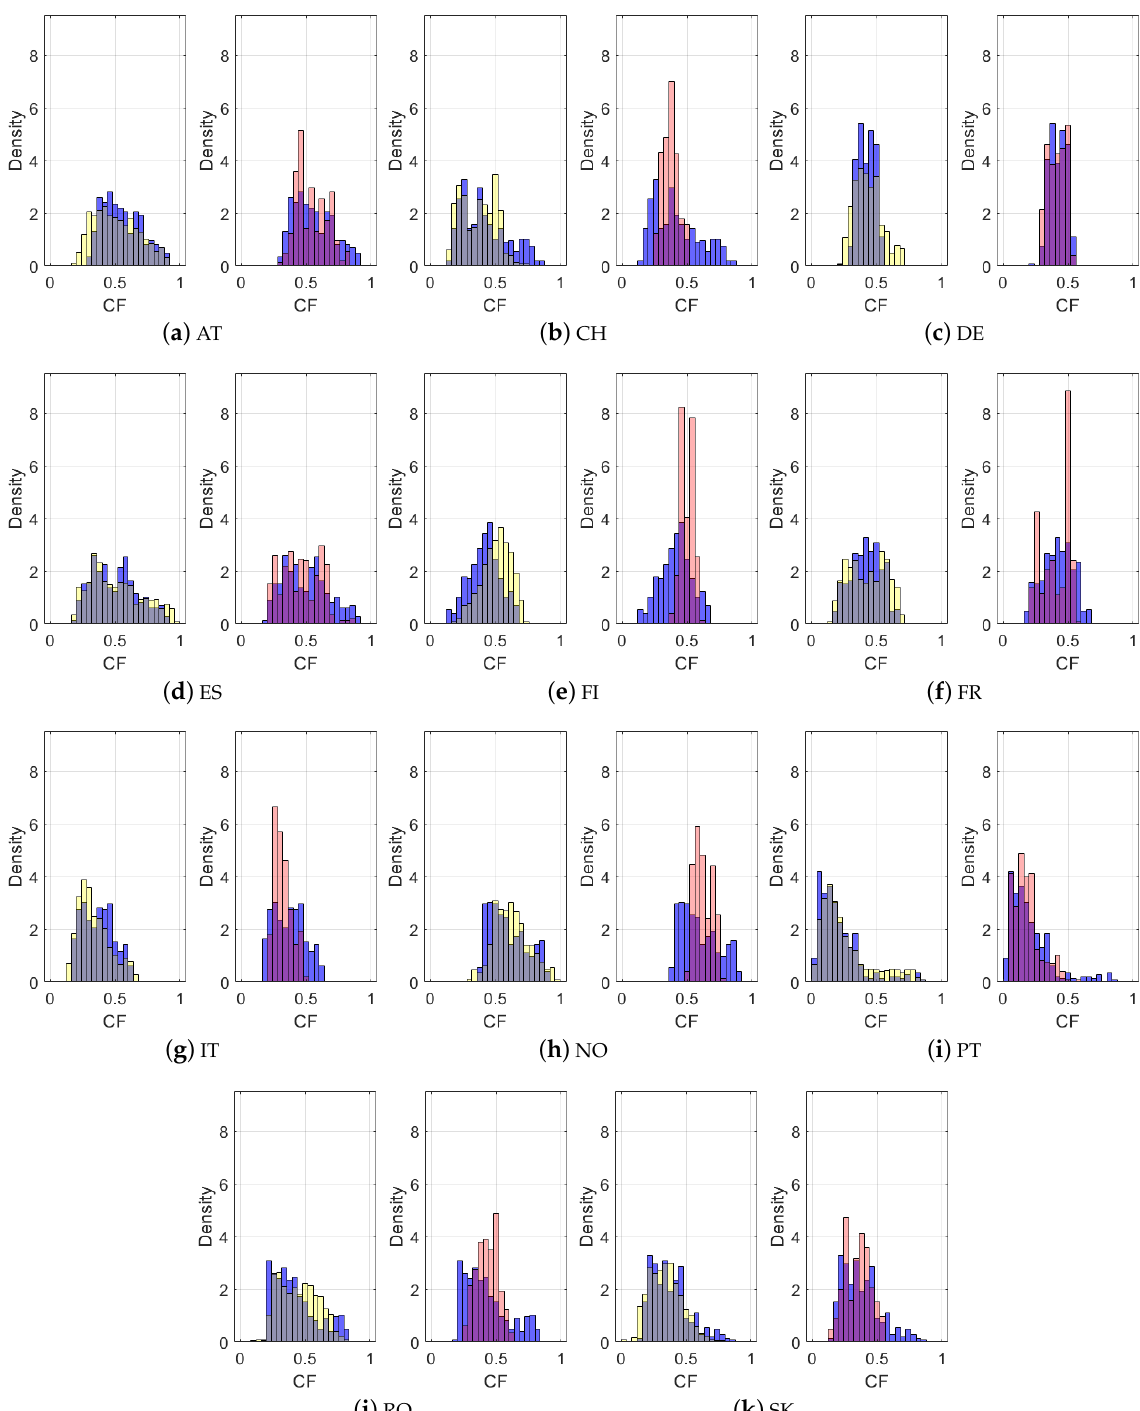
Figure 7. Leftmost panels: Distribution of the observed capacity factor (blue bars) compared with the distribution of the observed CF over the training period (yellow bars). The gray shade indicates the intersection of the two distributions. Rightmost panels: Distribution of the modeled time series (pink bars) compared with the observed distribution (blue bars). The violet shade indicates the intersection of the two